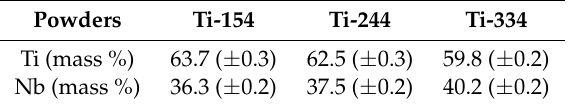
Table 4. Overall average Chemical composition of mechanically alloyed